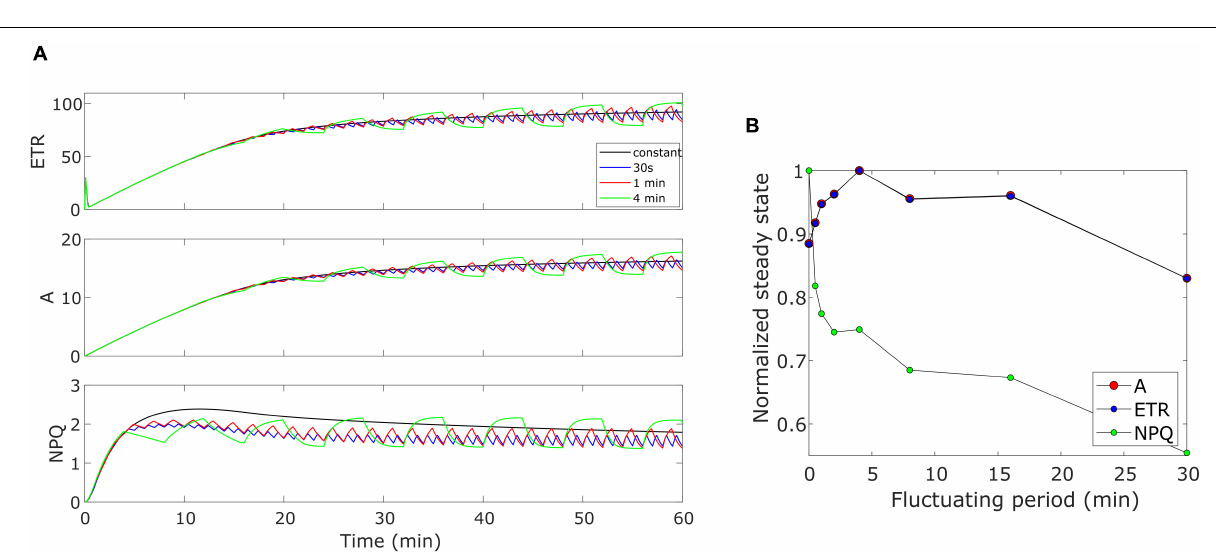
FIGURE 8 | (A) Varying fluctuating period of light in Eiko. Light is fluctuating every 30 s, 1 min (as in the experiment), and 4 min. (B) Effect of varying fluctuating light on the steady-state variable (cumulative value after 40 min). 0 fluctuating period means constant